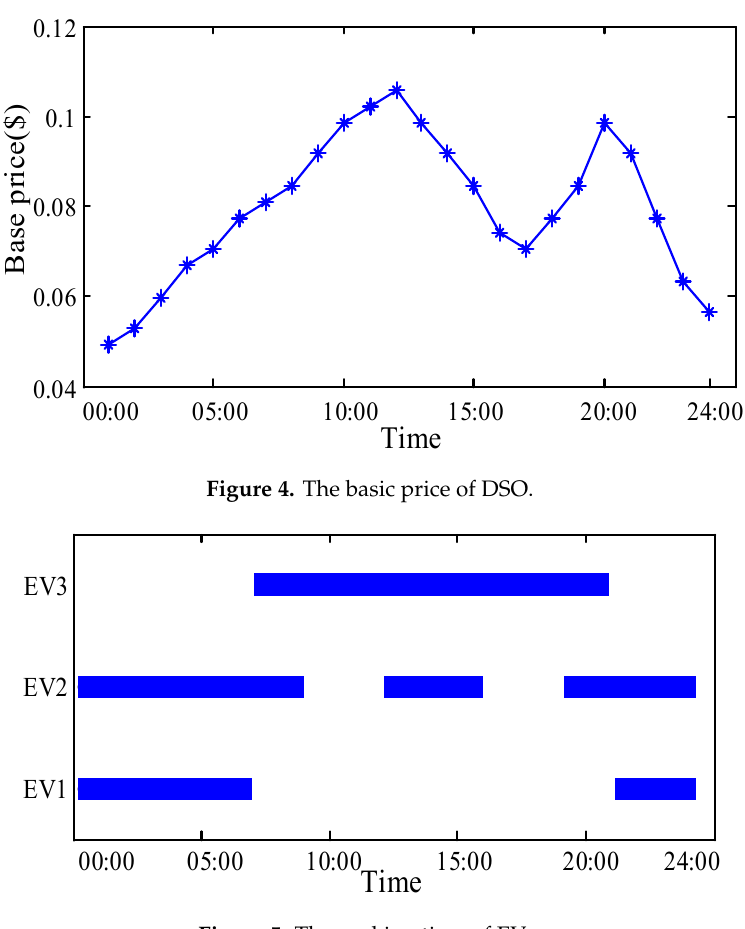
Figure 5. The parking time of EVs.